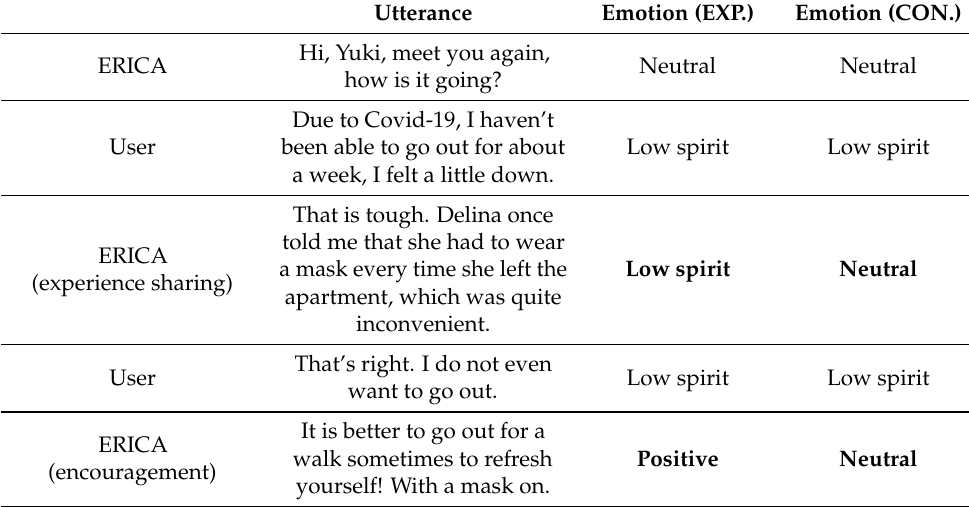
Table 4. An translated example of dialogue transcripts (the original script was in Japanese). Utterance Emotion (EXP.) Emotion